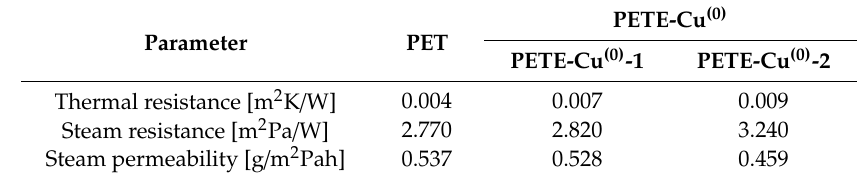
Table 7. Thermal resistance, steam resistance and steam permeability of the unmodified PETE fabrics and PETE-Cu (0) composites, according to the EN ISO 11092:2014-11